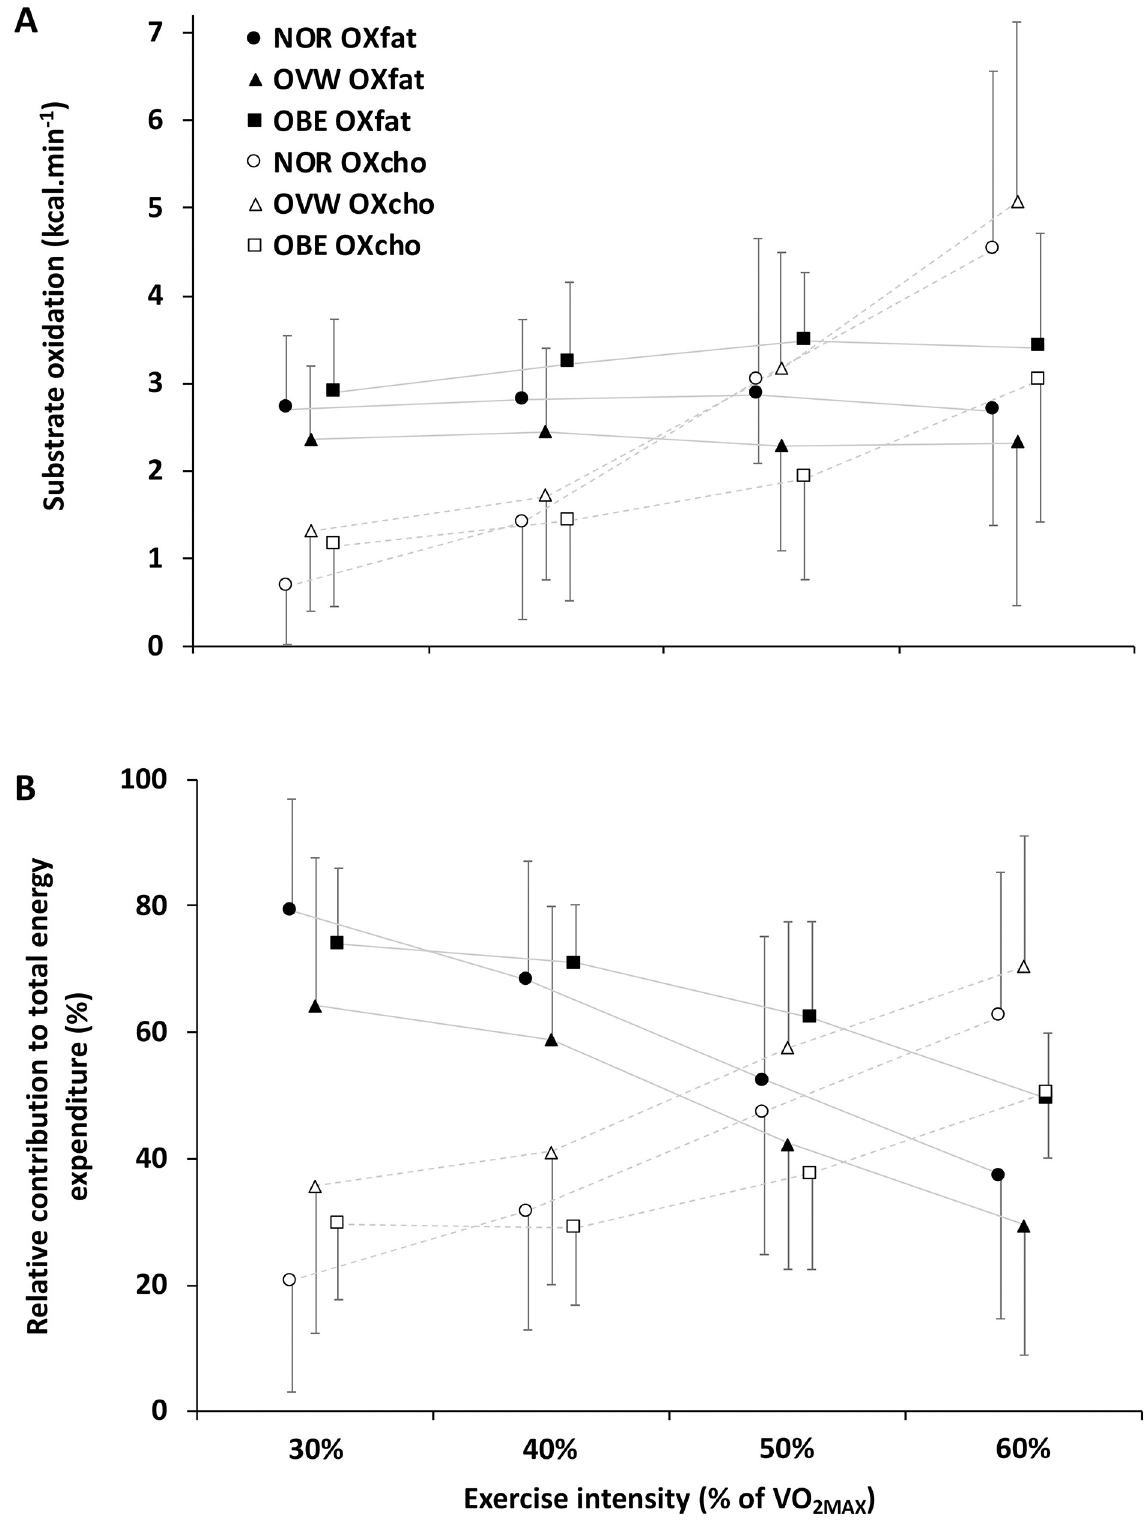
Fig 1. Substrate oxidation and energy expenditure. Absolute substrate oxidation (panel A) and relative contributions to total energy expenditure (panel B) for fat (OX FAT ) and carbohydrate oxidation (OX CHO ) during the submaximal graded test of participants classified according to BMI groups (NOR < 24.9 kg � m 2 ; OVW = 25–29.9 kg � m 2 ; OBE > 30 kg � m 2 ). https://doi.org/10.1371/journal.pone.0242551.g001 PLOS ONE | https://doi.org/10.1371/journal.pone.0242551 November18, 2020 8 /